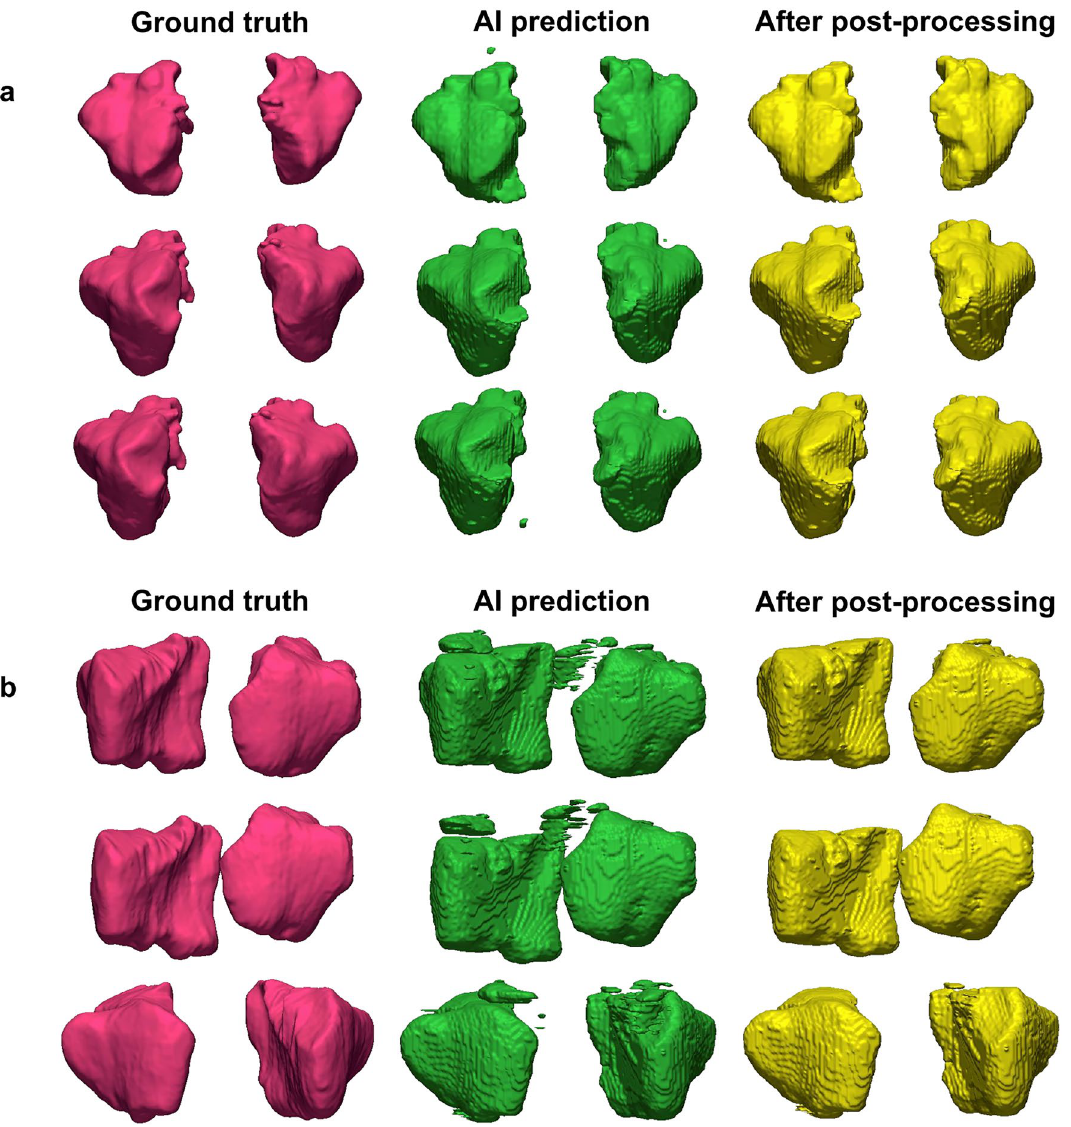
after post-processing of AI prediction. The average segmentation time per maxillary sinus was 48.7 min for the manual method and 46.2 s for the AI method, and the post-processing process took an average of 16 s.